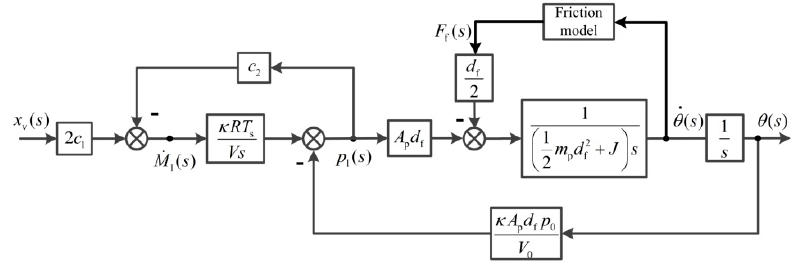
Figure 5. Block diagram of the valve-controlled actuator systems.